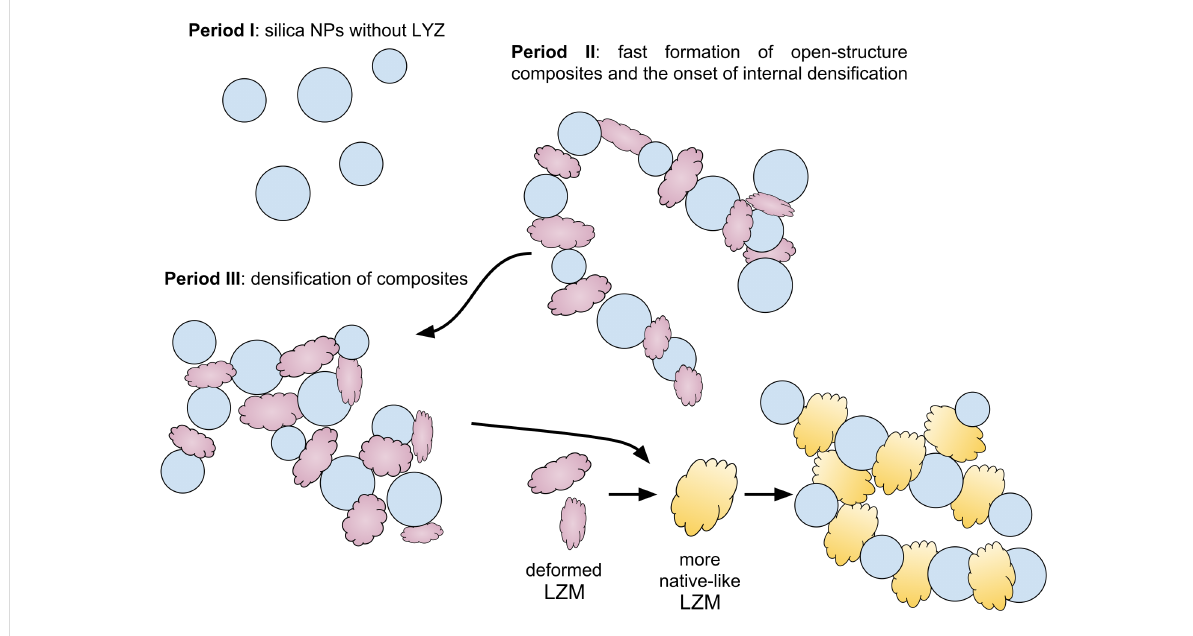
Figure 5: Schematic of the selected steps in the formation of silica–LZM composites as derived from the fast in situ and time-resolved SAXS data. Period I – unaggregated silica NPs (spherical in shape blue objects) before LZM addition. Following the LZM addition (cloud-like purple and yellow objects) occurs period II – fast aggregation to low-dimensionality fractal networks constituting the internal structure of large composite particles (primarily S agg ( q ) contribution); period III – internal densification of the network in the process of which the interparticle correlations develop (evolution of < S SHS ( q )> and S agg ( q )). At the early stages of densification the lysozyme molecules are strongly deformed within the aggregates; during further densification the protein molecules appear to relax to a more native